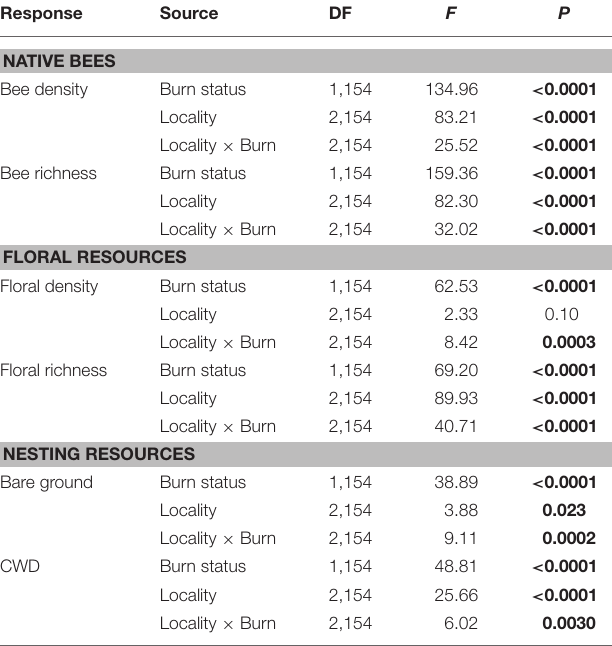
TABLE 1 | Results of two-way ANOVAs testing the effects of wildfire (i.e., burn status as burned or unburned), locality (i.e., Helena, Paradise, or Whitefish) and their interaction on native bee density and species richness, floral density and species richness, and nesting resources (i.e., bare ground and coarse woody debris [CWD]) measured across